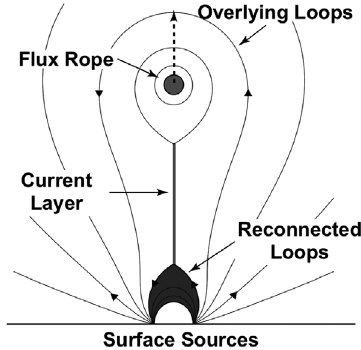
Fig. 1. Standard cartoon CME model. The fl ux rope extends through the page. Overlying fi elds resist the fl ux rope ’ s elevation and expansion. Magnetic reconnection releases the energy stored in the fi eld to accelerate the fl ux rope, producing a CME. Adapted from Forbes et al. (2018).